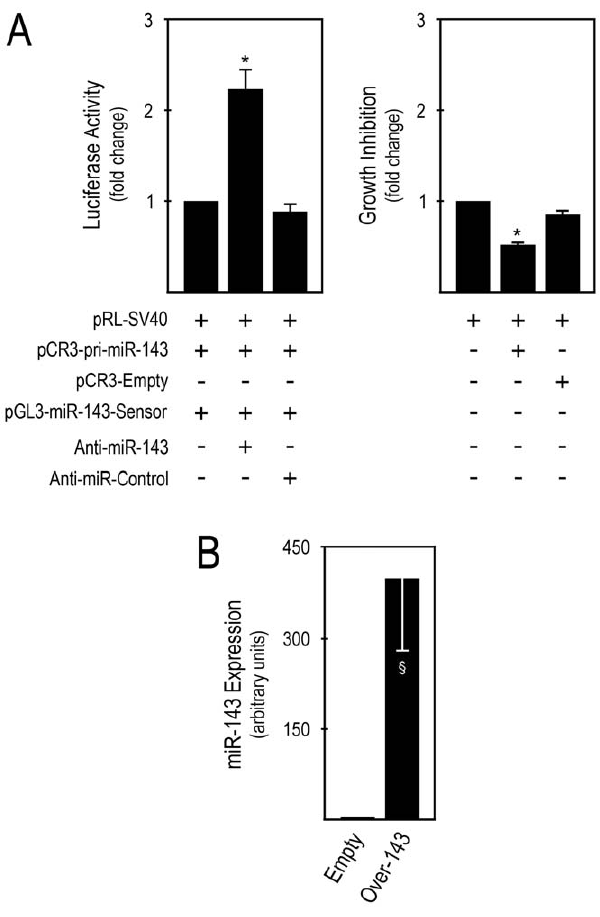
Figure. 1. Mature miR-143 overexpression increases cell growth inhibition. A, HCT116 cells were co-transfected with the indicated plasmids and anti-miR inhibitors, and analyzed 48 h post- transfection. Cells were lysed and firefly and renilla luciferase activities determined by the dual luciferase assay ( left panel ). Cell growth inhibition was evaluated by MTS metabolism assays, and cells were then lysed for dual luciferase assay, to normalize the MTS metabolism assay ( right panel ). B, HCT116 cells were transfected with pCR3-pri-miR- 143 and pCR3-empty and selected with G418, to generate Over-143 and Empty cells, respectively. Cells were harvested for total RNA extraction after 5 to 25 days of selection. miR-143 expression was evaluated from 1.4 m l cDNA of 10 ng total RNA RT reactions, using specific primers for miR-143 and RNU6B for normalization. miR-143 expression levels were calculated by the a˜a˜ C t method, using Empty cells as calibrator. Results are expressed as mean 6 SEM of at least 3 independent experiments. * p , 0.05 from controls and 1 p , 0.01 from Empty .